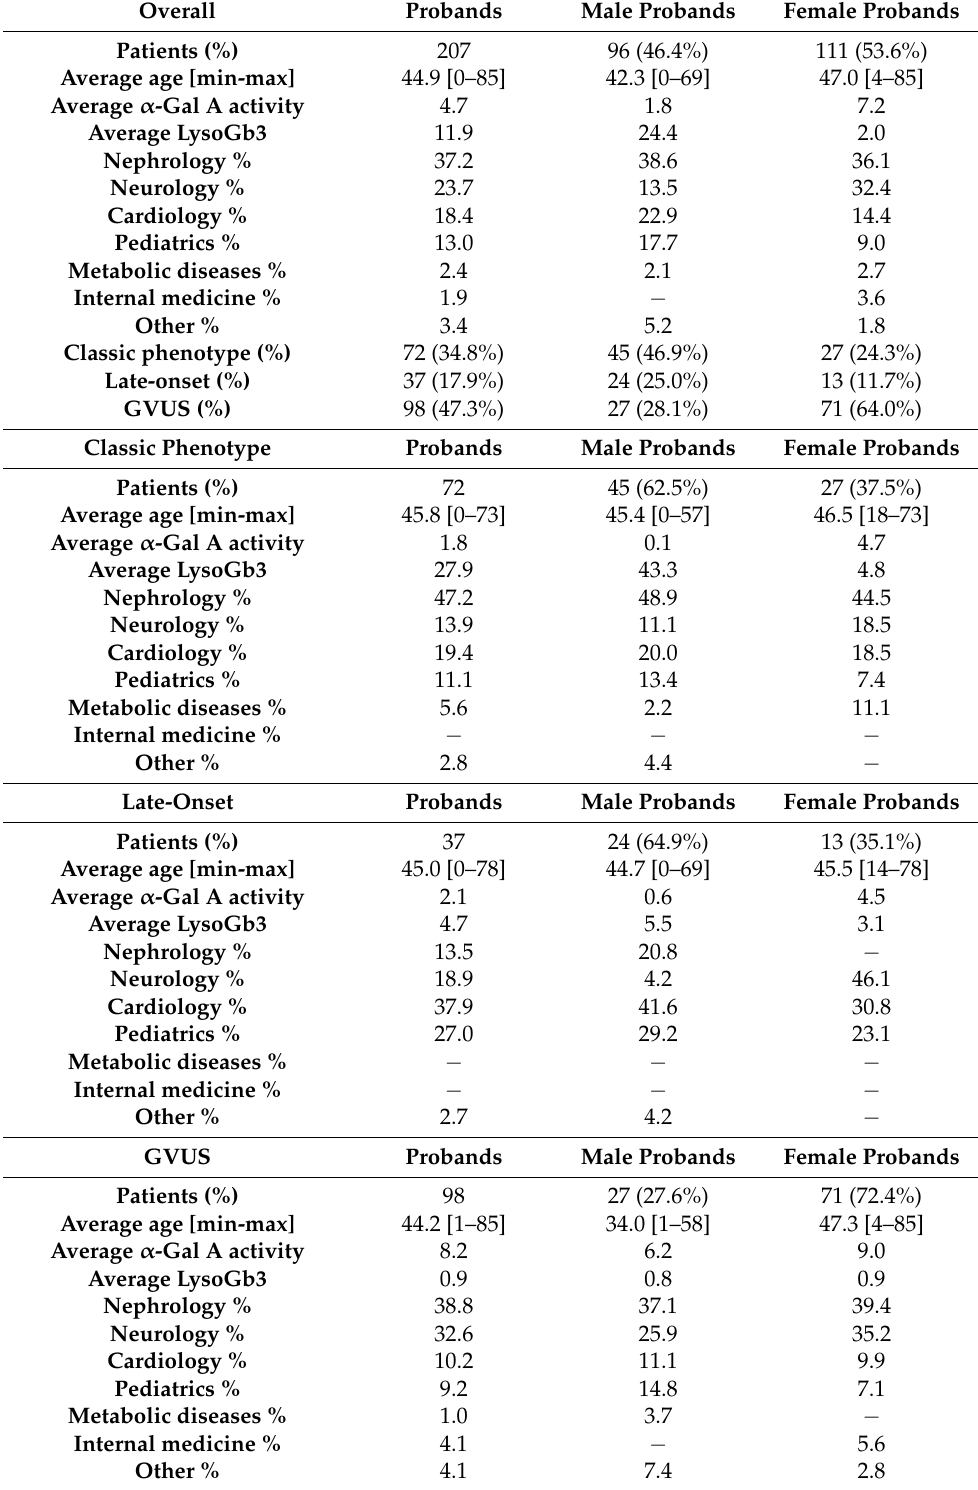
Table 1. Characteristics of the 207 Probands identified and the clinical unit from which they came. GVUS: genetic variants of unknown significance. Enzyme activity is measured in nmol/mL/h; normal values > 3 nmol/mL/h. LysoGb3 is measured in nmol/L; normal values 0.08–1.13